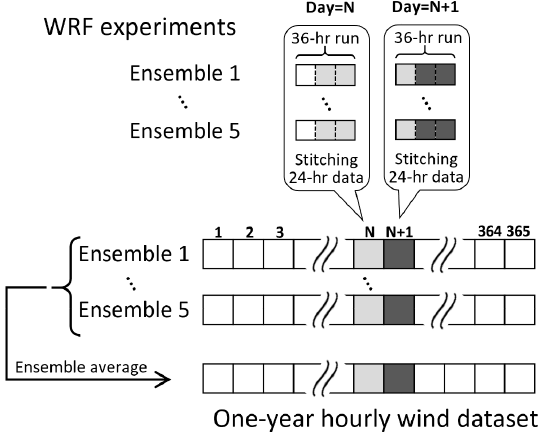
Figure 2. A flow chart summarizing the experiment and analysis procedures.